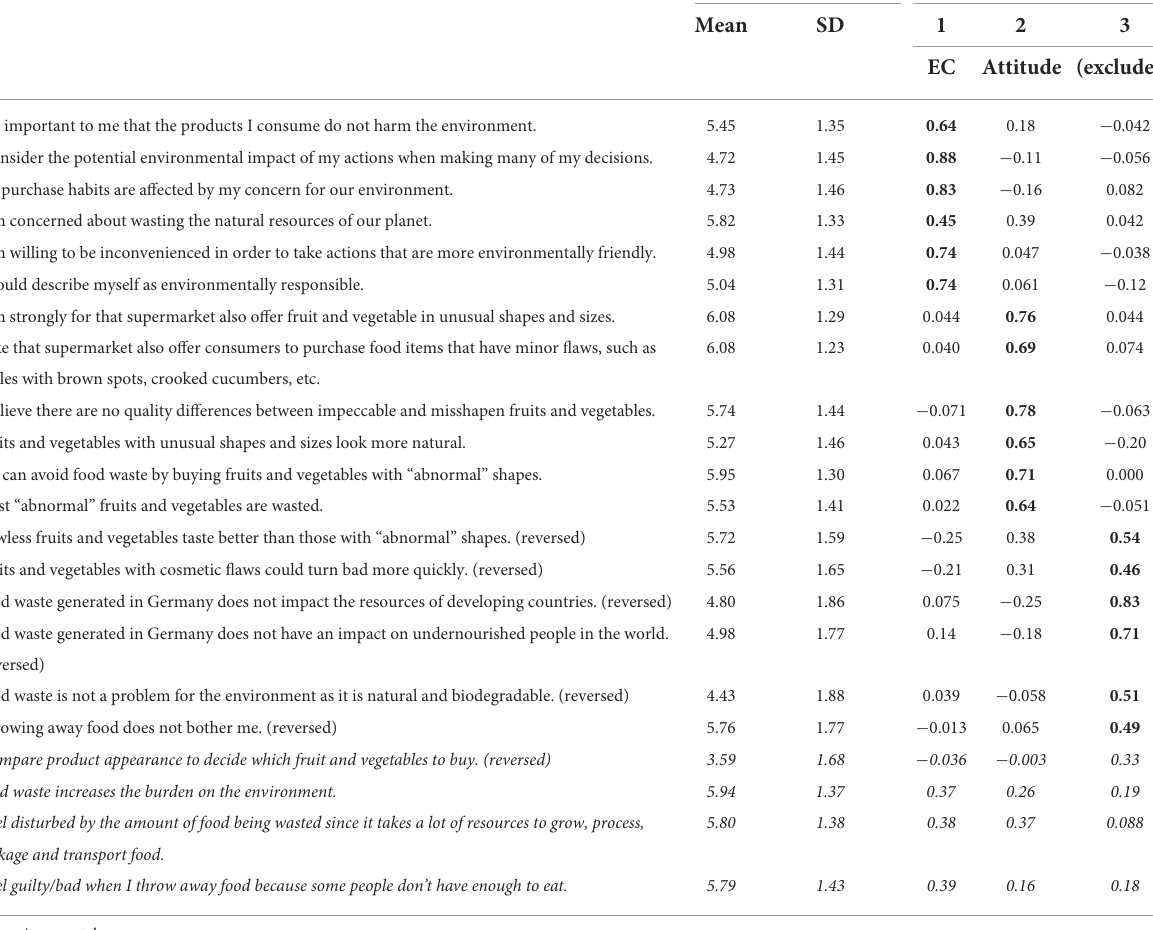
TABLE 3 Descriptive statistics and factor loadings of the items of the questionnaire for 493 participants.